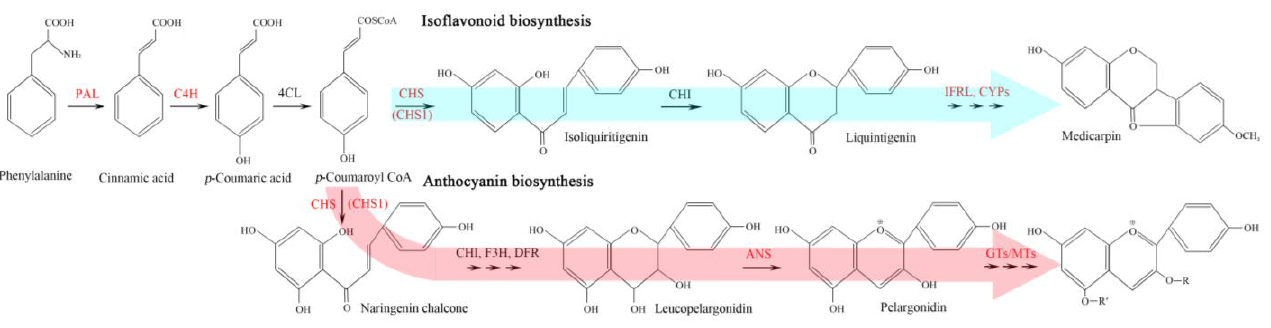
Figure 5. Flavonoid biosynthetic pathway with identified proteins and genes at high altitude shown in red. Enzymatic abbreviates: PAL—phenylalanine ammonia lyase; C4H—cinnamate 4-hydroxylase; 4CL—4-coumarate CoA ligase; CHS—chalcone synthase; CHI—chalcone